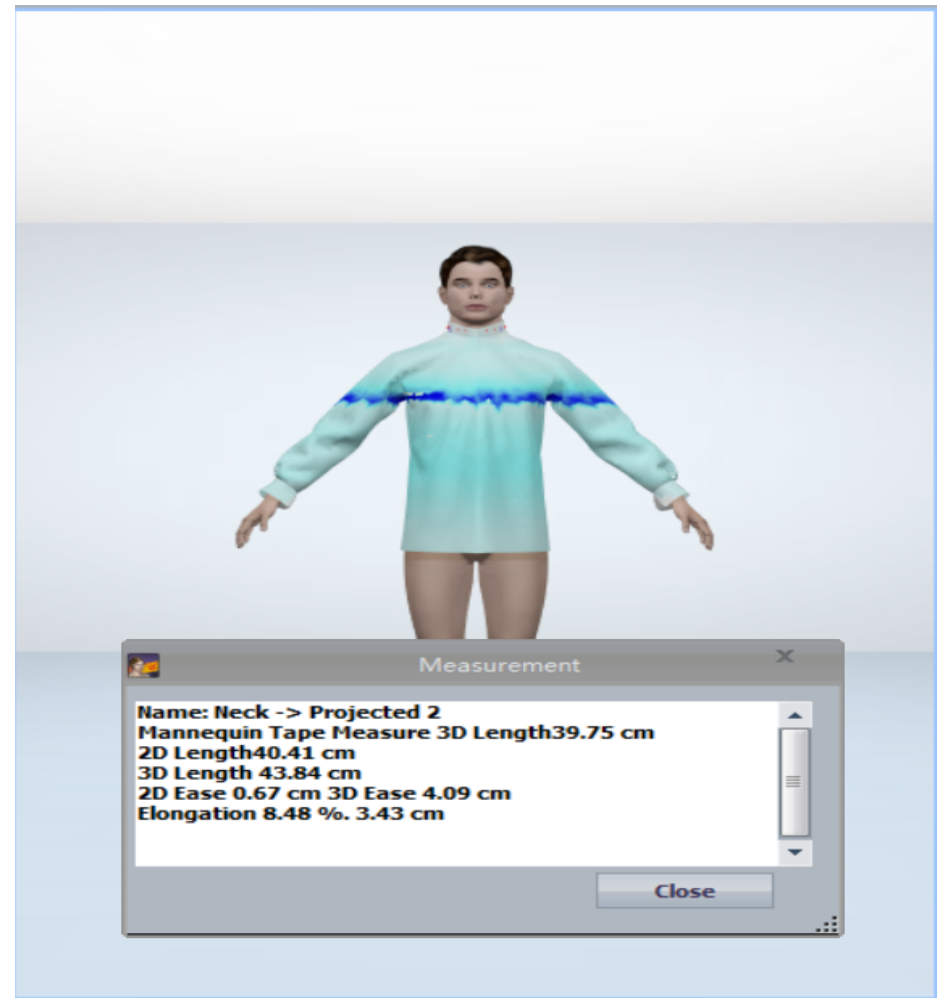
Figure 14. Shirt fitting before adjustment. Table 16. Satisfaction Levels for regular fitting design patterns (after adjustment).